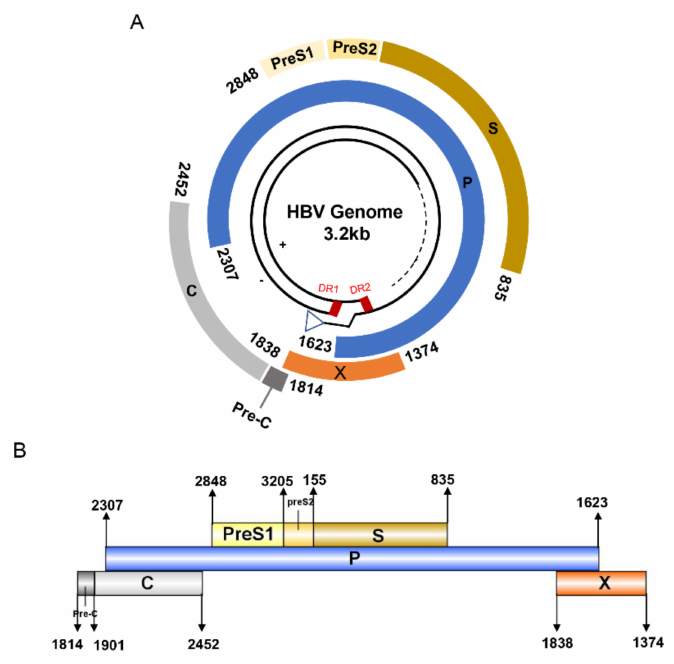
Figure 1. The circular ( A ) and linear ( B ) diagram of HBV